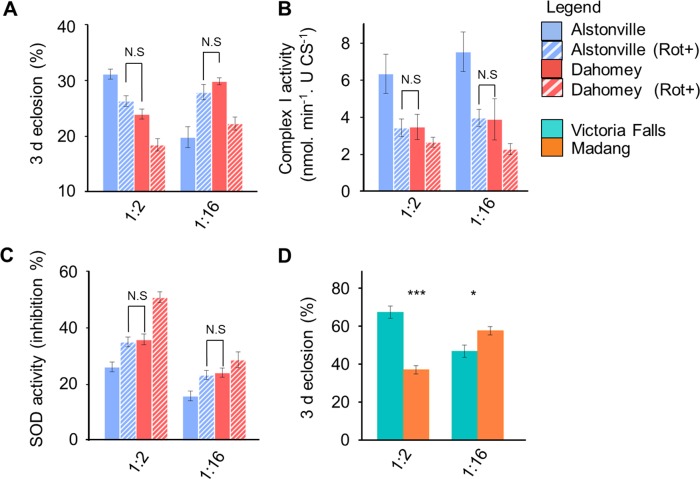
Corroboration that the complex I mutation in Dahomey drives the population cage results.(A) Adding rotenone to the Alstonville diet created a Dahomey phenocopy. This phenocopy developed more quickly than controls when fed the 1:16 P:C food showing that partial inhibition of complex I was beneficial. Adding rotenone to the Dahomey fly food created a disease model and these larvae developed more slowly on both diets (n = 5 biological rep/mitotype/diet with and without rotenone treatment). (B) Complex I activity was decreased in the phenocopy, mimicking the Dahomey mitotype (n = 7 biological rep/mitotype/diet without rotenone treatment and 6 biological rep/mitotype/diet with rotenone treatment). (C) SOD activity increased in rotenone-treated larvae. On both foods, SOD activity in the phenocopy was not different from the Dahomey mitotype (n = 5 biological rep/mitotype/diet with and without rotenone treatment). (D) Larval development times of D. melanogaster harbouring the Madang (with the V161L ND4 mutation) and the Victoria Falls (without the ND4 mutation) mitotypes shows the same flip in development times as Dahomey and Alstonville (n = 6 bottles/mitotype/diet). Plotted data were mean± s.e.m. * p< 0.05 and ** p< 0.001, as calculated by t-tests (see text). Note: complete post-hoc analyses including all treatments for panels A-C are presented in S5 Fig.